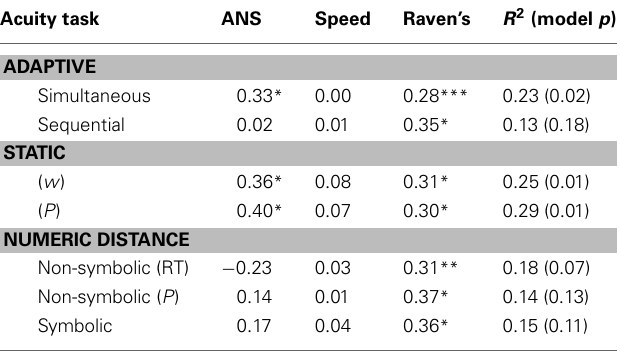
Table 4 | Multiple regression models for each ANS acuity measure, with basic arithmetic fluency (addition and subtraction) as dependent variable and perceptual speed, intelligence (Raven’s matrices) as predictors.